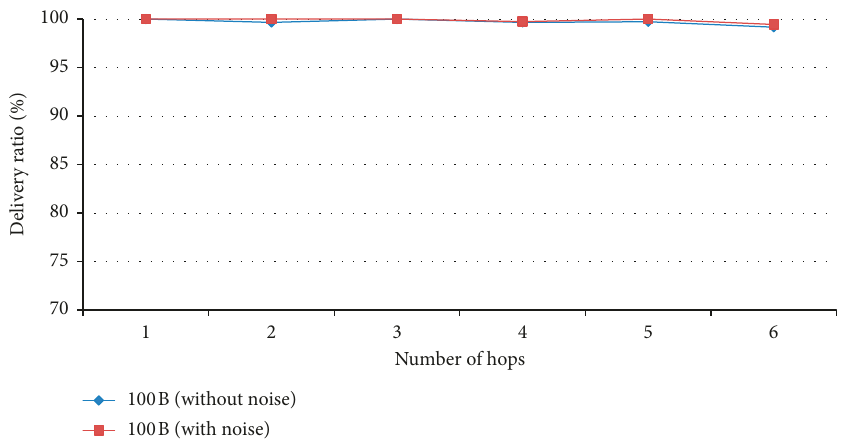
Figure 8: Delivery ratio as a function of the number of hops.